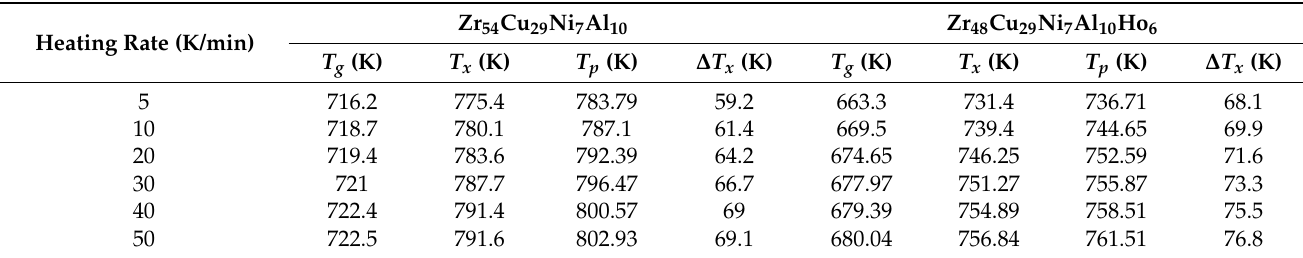
Table 2. Characteristic temperatures of Zr54 BMG and Zr48Ho6 BMG at various heating rates.